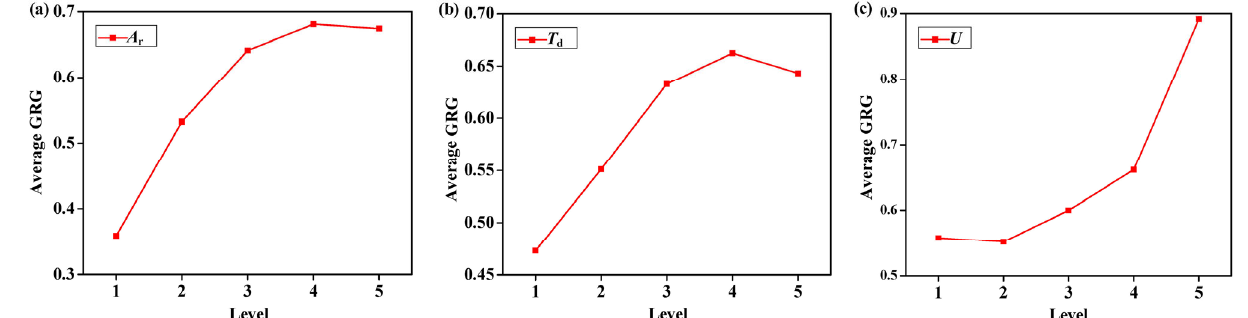
Fig. 16 Influence of curved bottom profile texture design variables (a) aspect ratio, (b) texture density, and (c) flow speed on output responses.